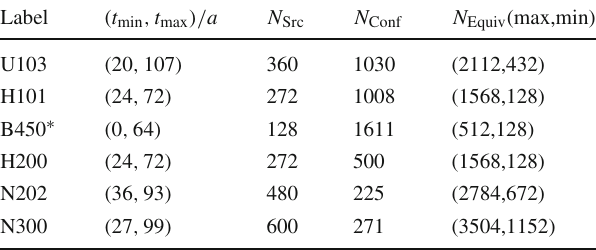
Table 8 The setup used for each ensemble in the computation of the quark-disconnected contribution. N Src gives the number of propagator inversions per configuration, N Conf gives the number of gauge config- urations used and N Equiv gives the maximum and minimum number of equivalent values of | y | averaged per configuration. Shorter sepa- rations have larger numbers of self-averages, whereas larger values of | y | have smaller N Equiv . The ensemble B450 has a periodic temporal boundary and temporal length of 2 × that of the the spatial, so values of y / a = n ( 2 , 2 , 2 , 4 ) could be used, as well as the full periodicity